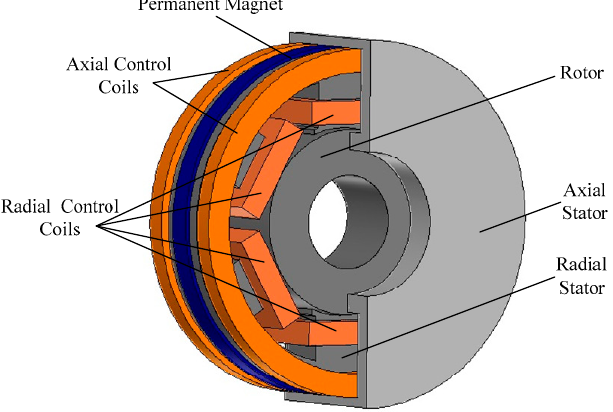
Figure 9. 3 ‐ D finite element method (FEM) model of the six ‐ pole radial ‐ axial hybrid magnetic Figure 9. 3-D finite element method (FEM) model of the six-pole radial-axial hybrid magnetic bearings (HMB). bearings